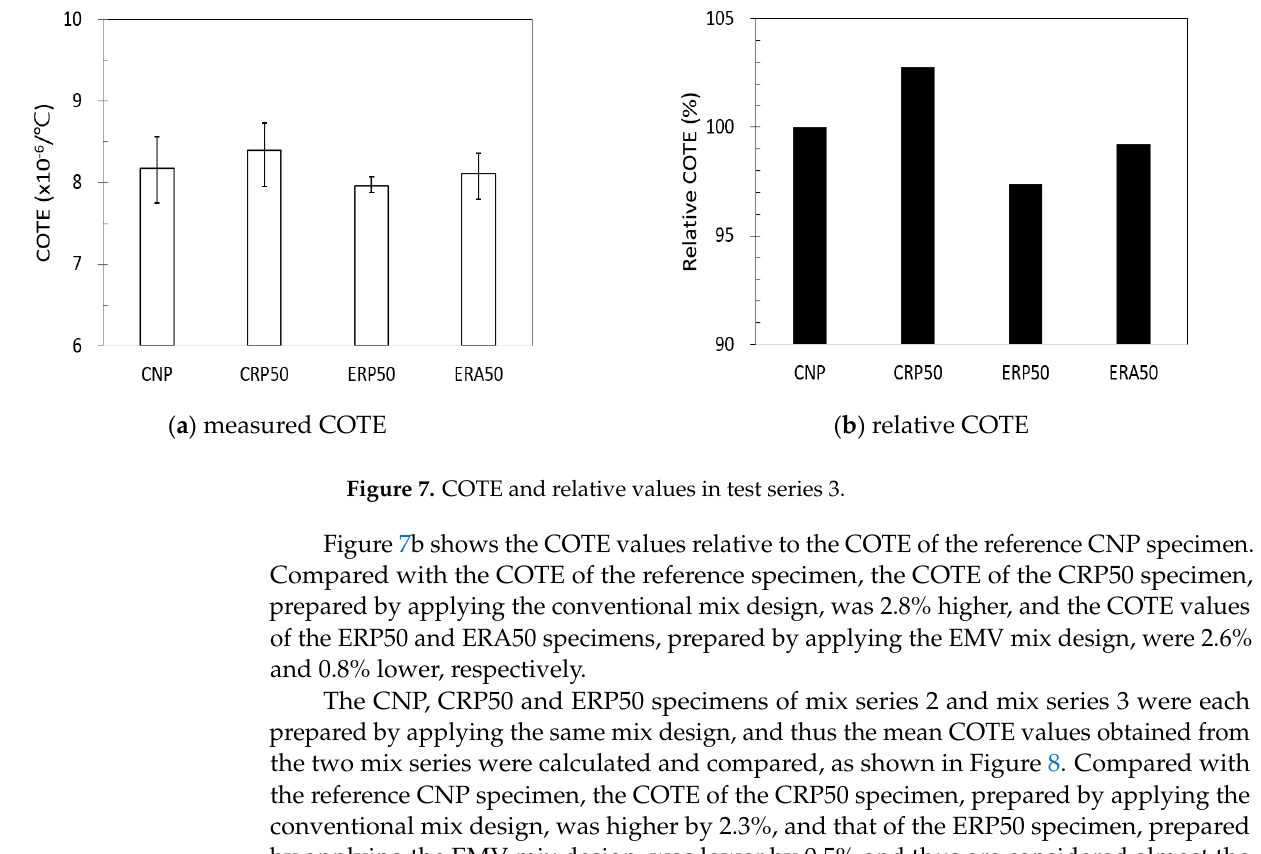
Figure 8. Average relative COTE values from mix series 2 and 3. 4.2.1. Dependence of Total Coarse Aggregate Volume In the present study, both RCA and NCA were based on similar granite aggregates, and thus the effect of the aggregate type was considered to be negligible. Assuming that concrete comprises coarse aggregate and mortar (water, cement, fine aggregate, air void), it was predicted that the COTE of concrete would increase as the volumetric ratio of mor- tar increased or that the COTE of concrete would decrease as the volumetric ratio of the coarse aggregate increased. Using Equation (3), the total coarse aggregate volume in the mix was calculated using the data shown in Tables 1 and 2: (cid:1848) (cid:3021)(cid:3004)(cid:3002) =